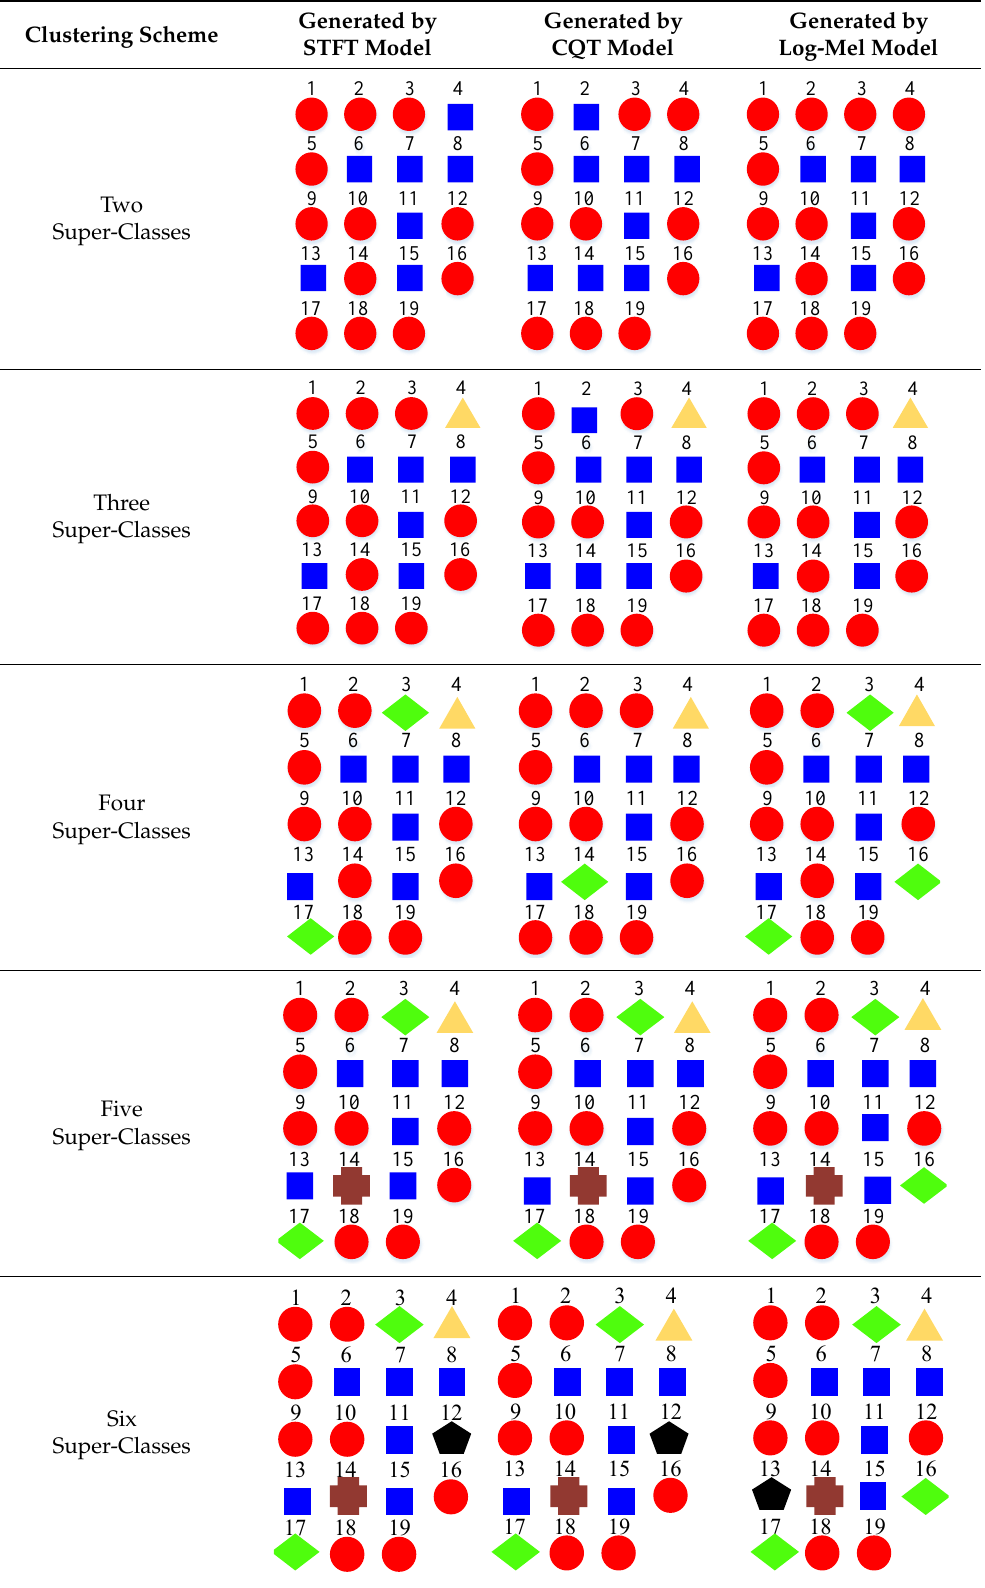
Table 4. Clustering details of the constructed super-class for the LITIS Rouen dataset. The classes marked by the same shape with the same color are grouped into the same super-class.